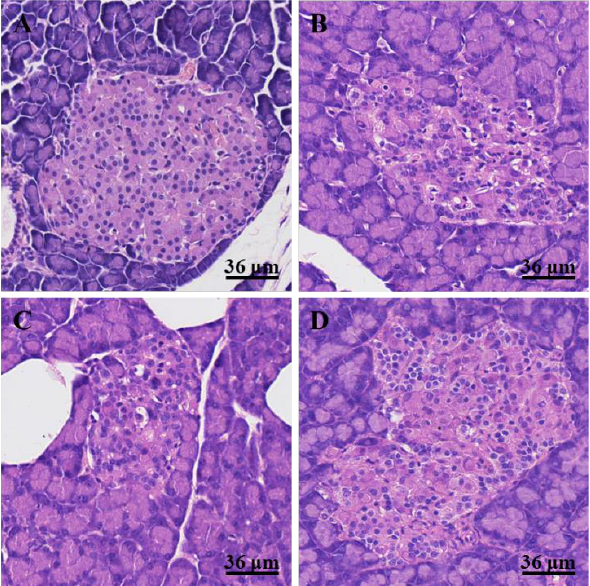
Figure 2. The H&E staining of the pancreas (HE 40×) in four groups. ( A ) NC, normal control group; ( B ) DM, diabetes model group; ( C ) KIDF, kiwifruit insoluble dietary fiber treatment group; ( D ) KSDF, kiwifruit soluble dietary fiber treatment group. Table 2. Effects of KIDF or KSDF on SCFAs produced in